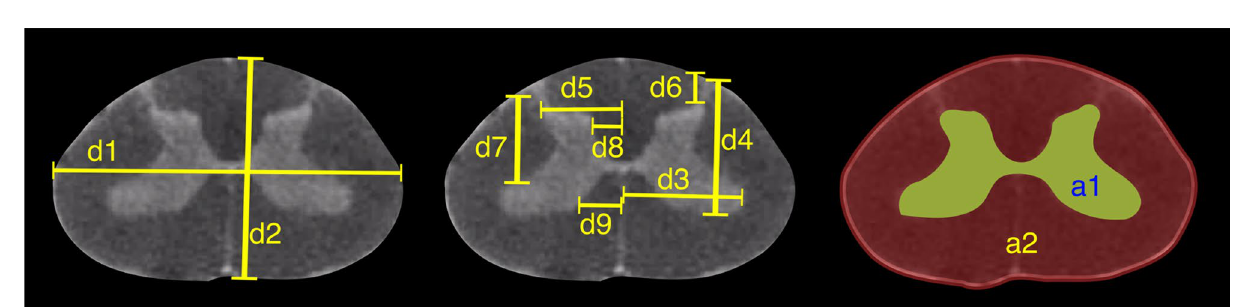
Figure 7. MRI-based morphometric measurements of the lumbosacral spinal cords of rat, cat, pig, monkey, and human. d1 and d2 represent the width and height of the spinal cord, respectively. d3 and d9 are the mediolateral distances from the midline to the lateral and medial boundaries of the ventral horn. Similarly, d5 and d8 are the mediolateral distances from the midline to the lateral and medial boundaries of the dorsal horn. d7 and d4 are the depth of the dorsal and ventral boundaries of the ventral horn from the spinal cord surface. d6 is the depth of the dorsal boundary of the dorsal horn. a2 and a1 represent the cross-sectional areas of the spinal cord and the gray matter,